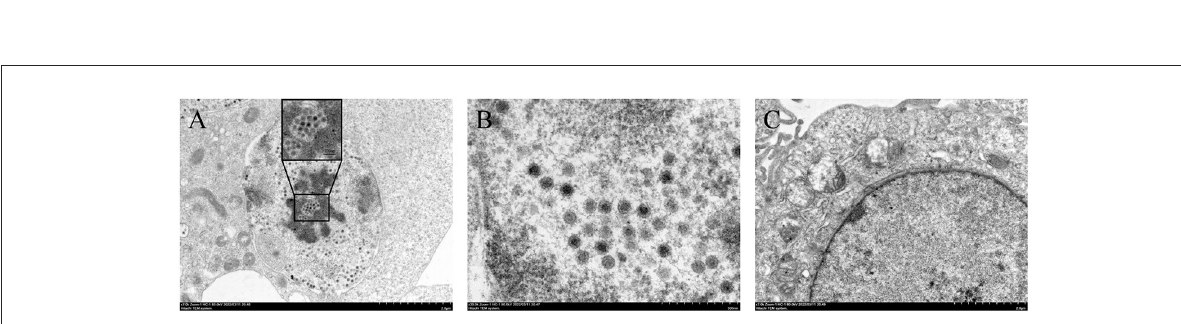
Phylogenetic tree based on hexon loop-1 gene showed that strain GX01 was most closely related to FAdV-2 strain 685 (Figure